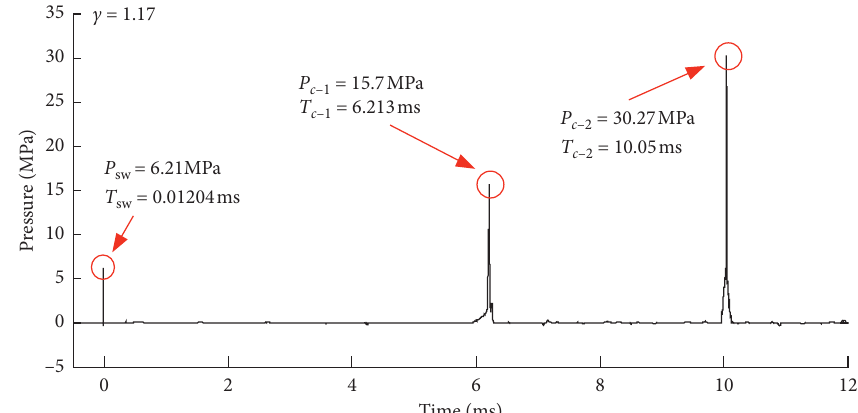
Figure 33: Pressure-time diagram of the first and second cycles of the spark-generated bubble load for c � 1.17.